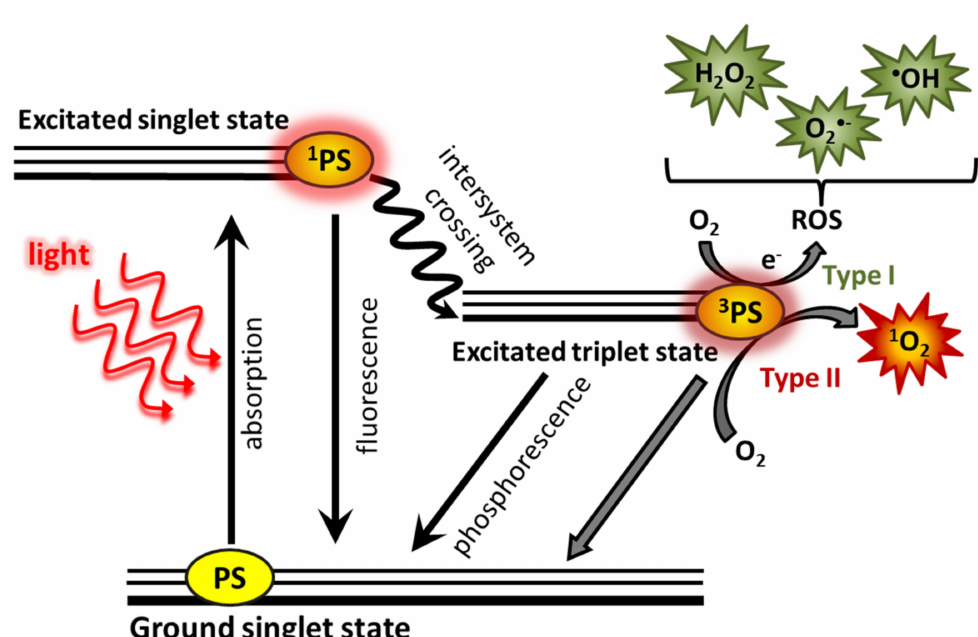
Figure 1. Mechanism of photosensitizer (PS) activation. Under illumination PS absorbs a photon and pass from a singlet ground state to a singlet excited state, and then, as a result of relaxation, to a triplet state. PS in the triplet state can interact with oxygen in a type I reaction to form reactive oxygen species (ROS) or in a type II reaction, leading to the formation of singlet